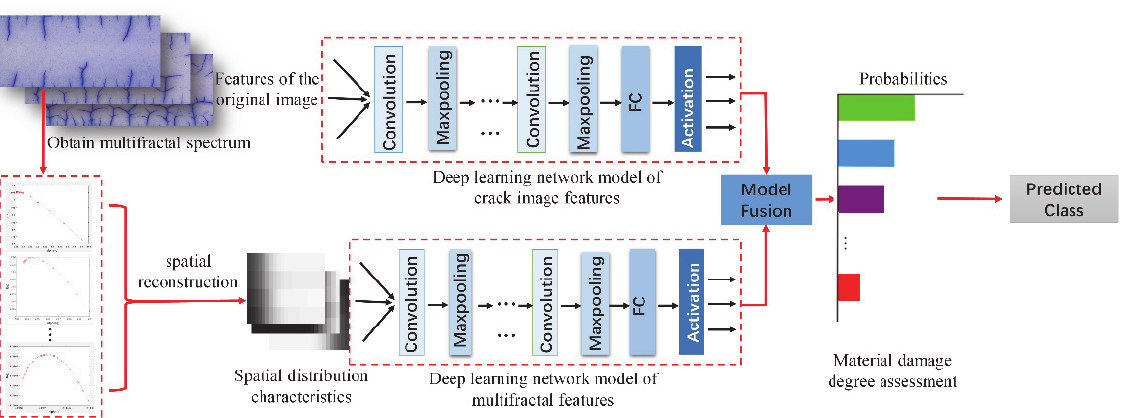
Figure 2. Deep learning-based fusion model between crack propagation characteristics and the thermal shock damage.